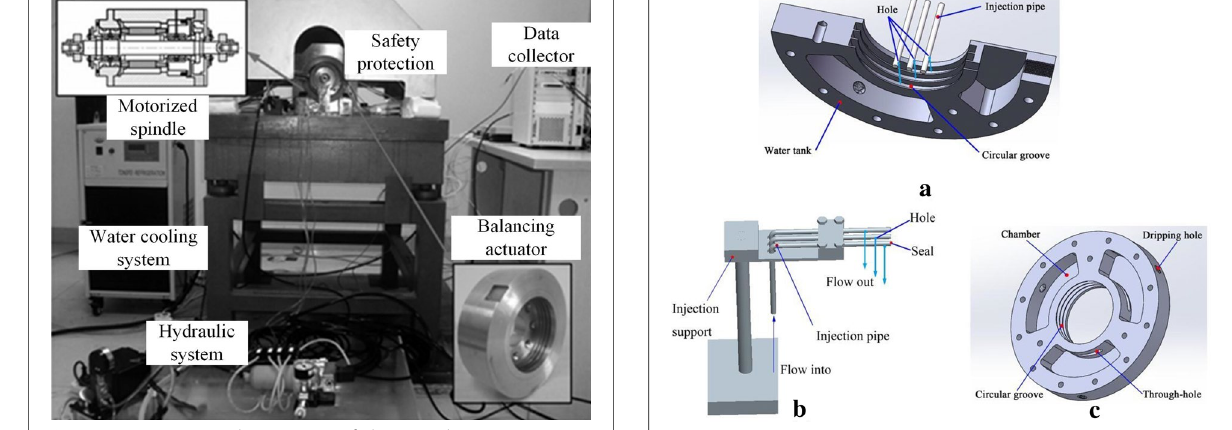
Figure 31 Experimental equipment of Zhang et al. [113] Figure 32 Balancing actuator of Zhang et al.